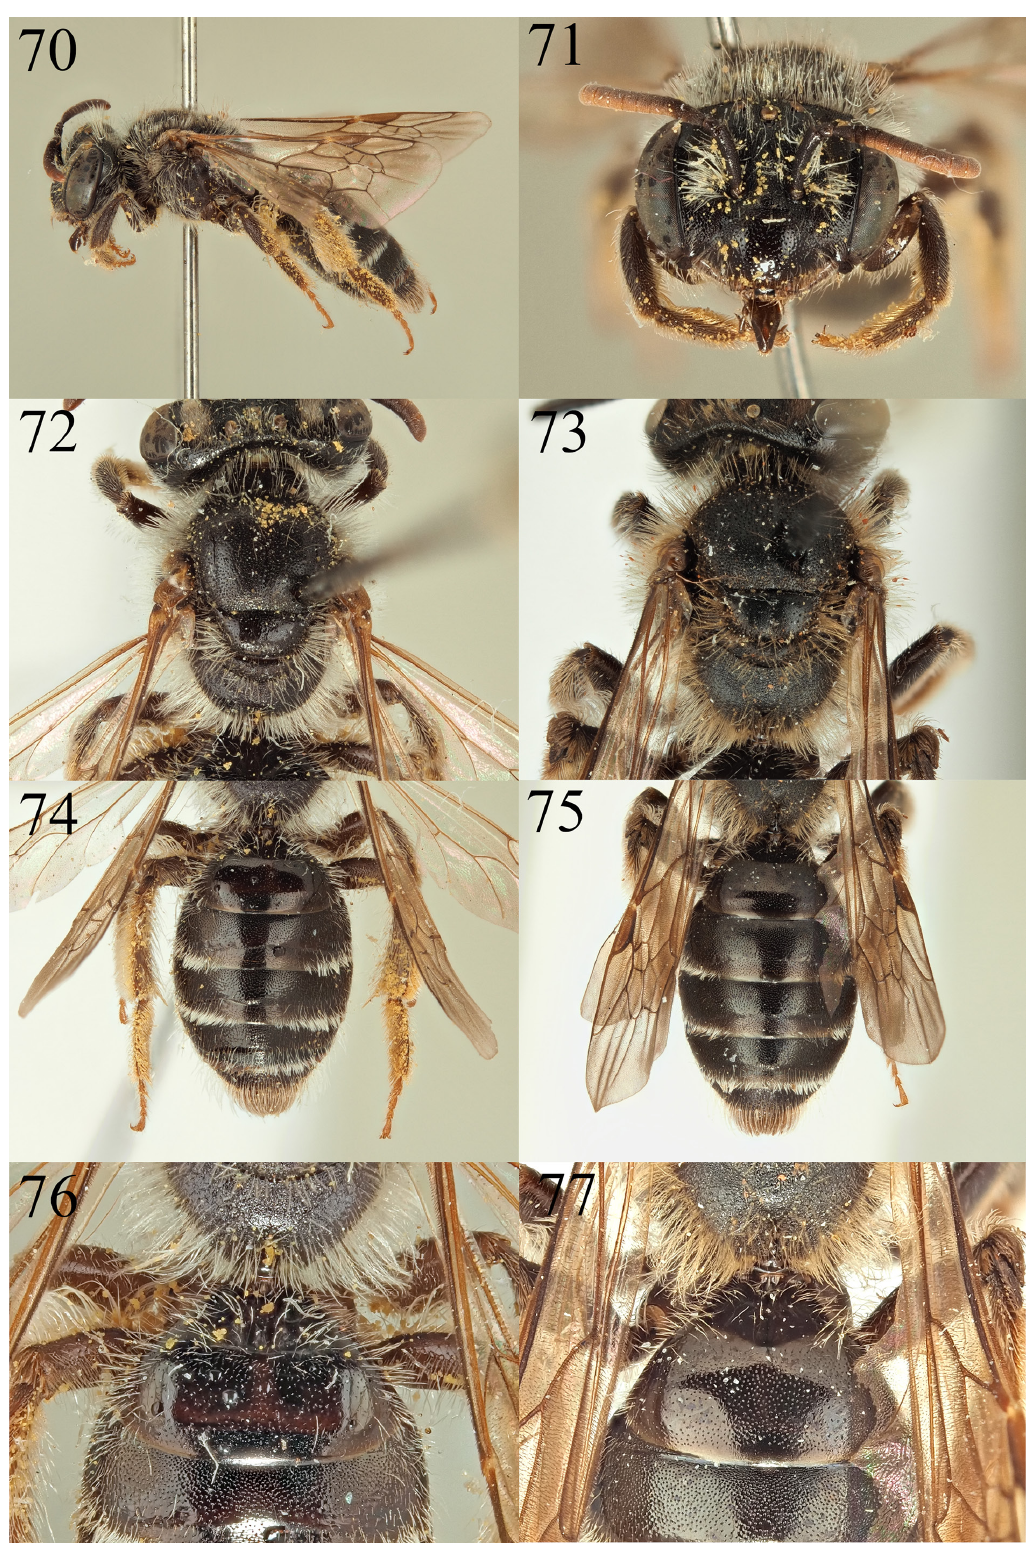
Figs 70–77. 70–72, 74, 76. Andrena juliana Wood sp. nov. (NMNL). 70 . Female profile. 71 . Female face. 72 . Female scutum. 74 . Female terga. 76 . Female terga detail. — 73, 75, 77 . Andrena